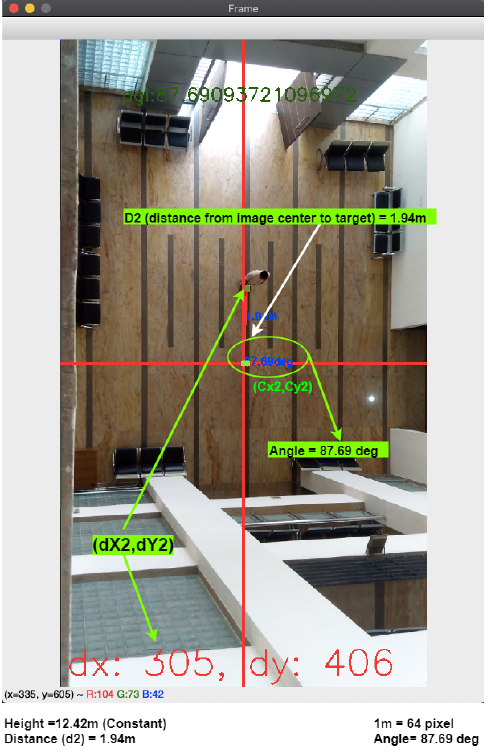
Figure 9. Parameter estimation and target localization in drone 2 image. Table 6. Scenario based